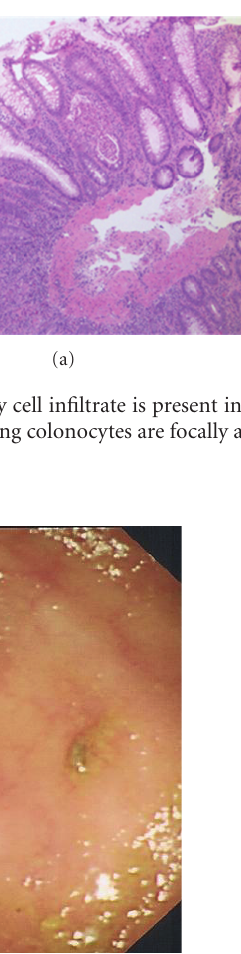
Figure 3: Resolution of colonic ulceration following discontinua- tion of